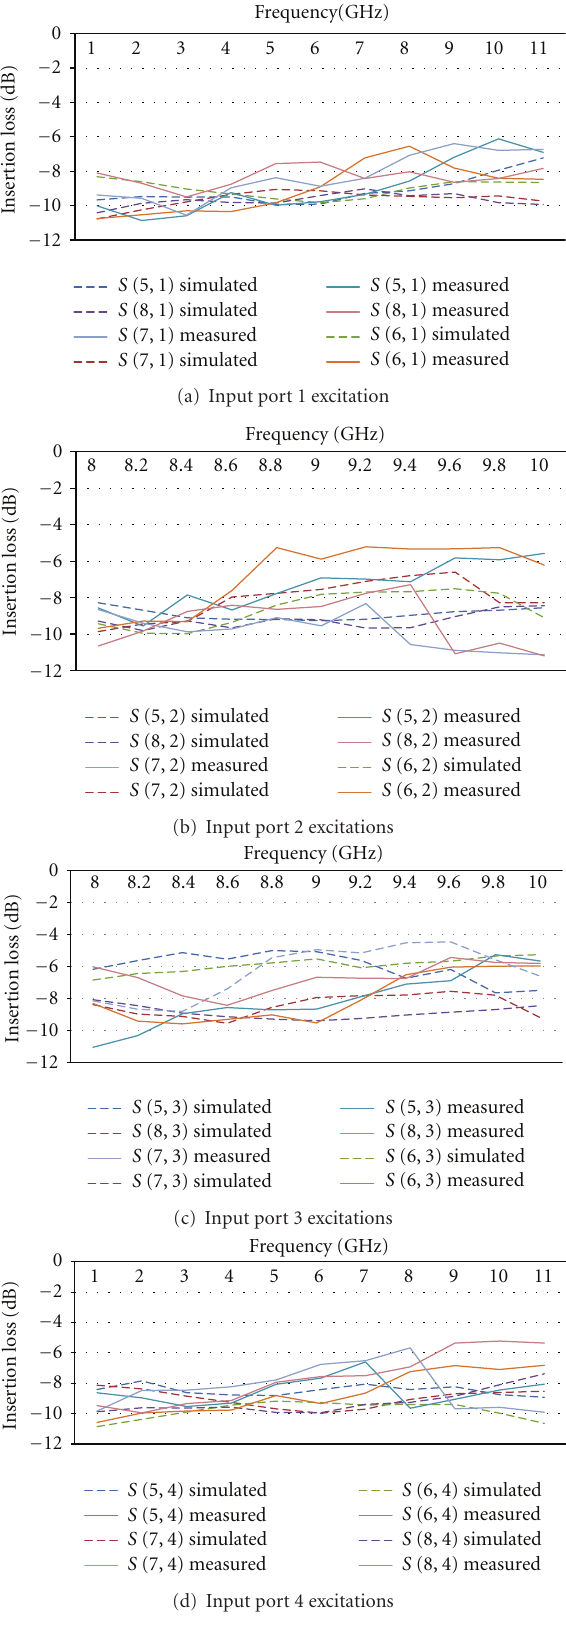
Figure 11: Insertion loss of the proposed Butler Matrix when di ff erent ports are fed.